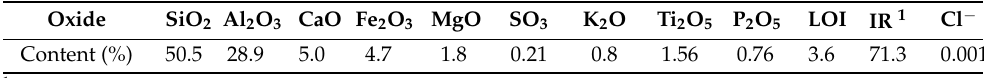
Table 1. Average chemical compositions of coal fly ash (%). Oxide